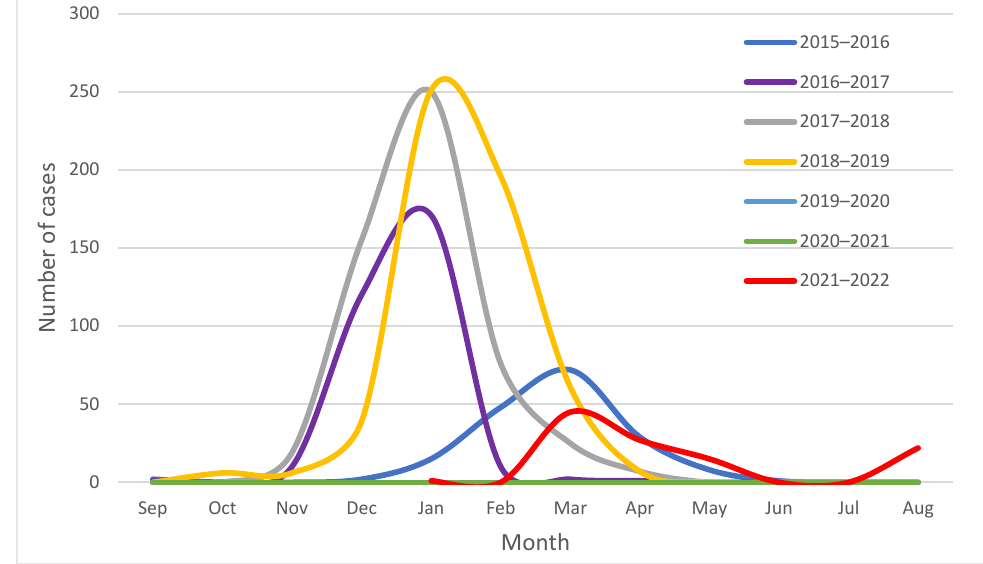
Figure 1. Seasonal circulation pattern of influenza viruses in the Apulia region of Italy, from season